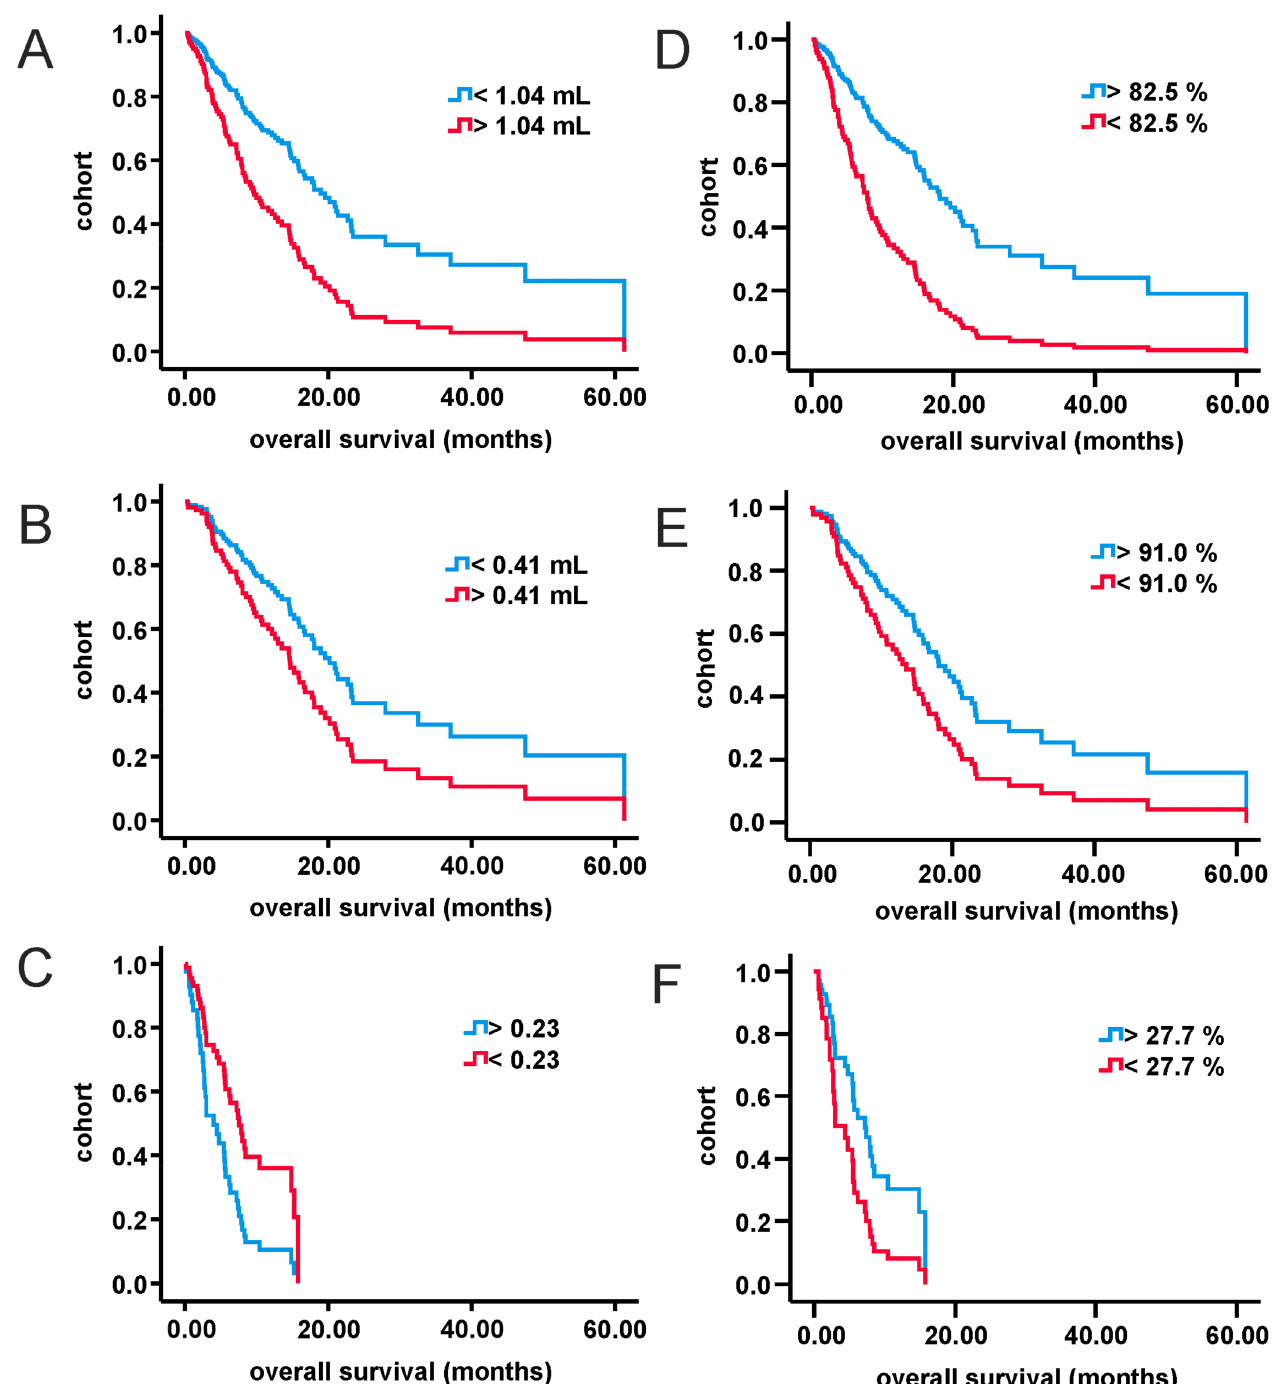
Figure 2. Cox regression of categorized volumetric parameters for all three study cohorts. ( A ): entire cohort, residual tumor volume; ( B ): uGBM, residual tumor volume; ( C ): mGBM, ratio of tumor necrosis volume to initial tumor volume; ( D ): entire cohort, extent of resection; ( E ): uGBM, extent of resection; ( F ): mGBM, extent of resection. mGBM: multifocal glioblastoma; uGBM: unifocal